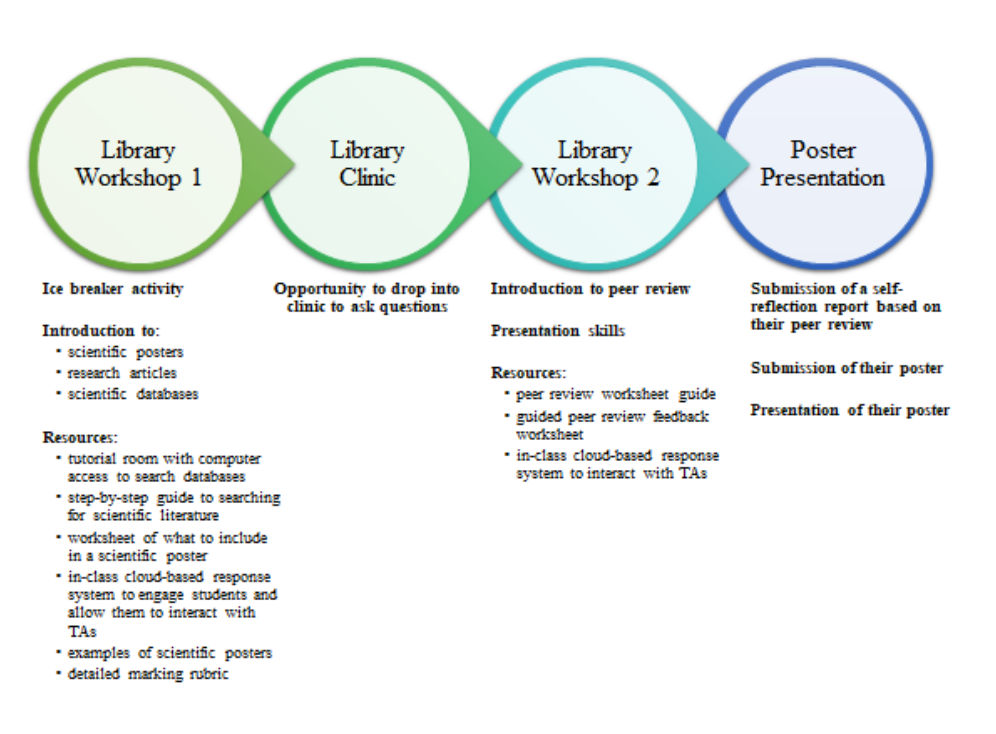
Figure 1. A schema of the peer review and scientific poster assessment task activities as undertaken by the